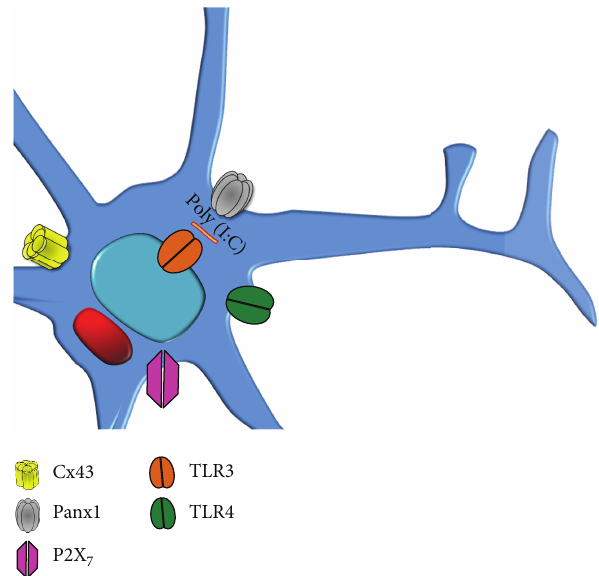
Figure 1: Expression of toll-like receptors in microglia and their relationship with pannexin channels and P2X 7 receptors. Microglia express TLRs 1 to 9, and in this figure only, TLRs 3 and 4 are shown responding to pathogen-associated molecular patterns of virus (TLR3) and Gram negative bacteria (TLR4). TLR3 is expressed in endosomal membranes (and also in cell surface) and recognizes nucleic acids of virus (dsRNA) and poly (I:C). We propose that microglia under activation with TLR ligands increase the expression of Panx1 channels and connexin HCs and the activity of P2X 7